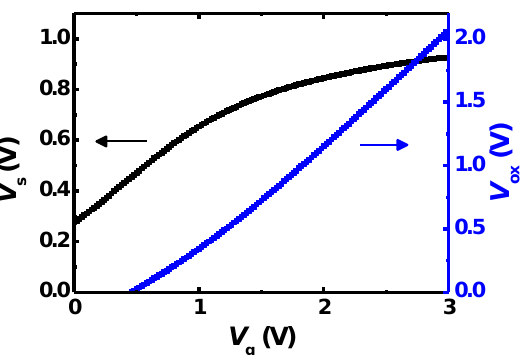
Figure 3. The voltage drops across the RRAM stack ( V ox , the curve in blue) and substrate ( V s , the curve in black) when the device is positively biased.